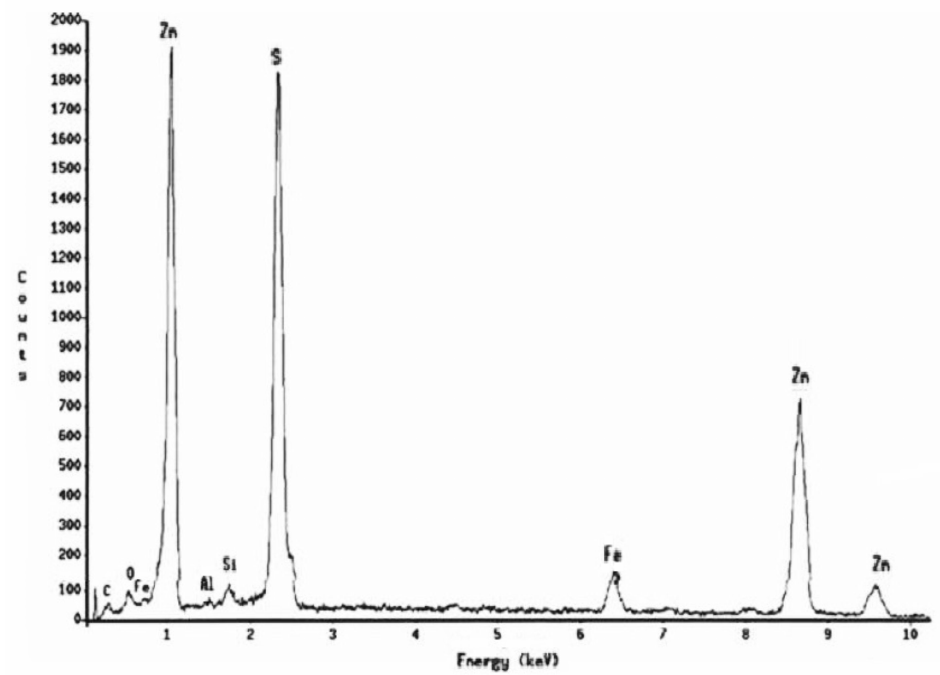
Figure 14. Microanalysis of sphalerite particles shown in Figure 13, before